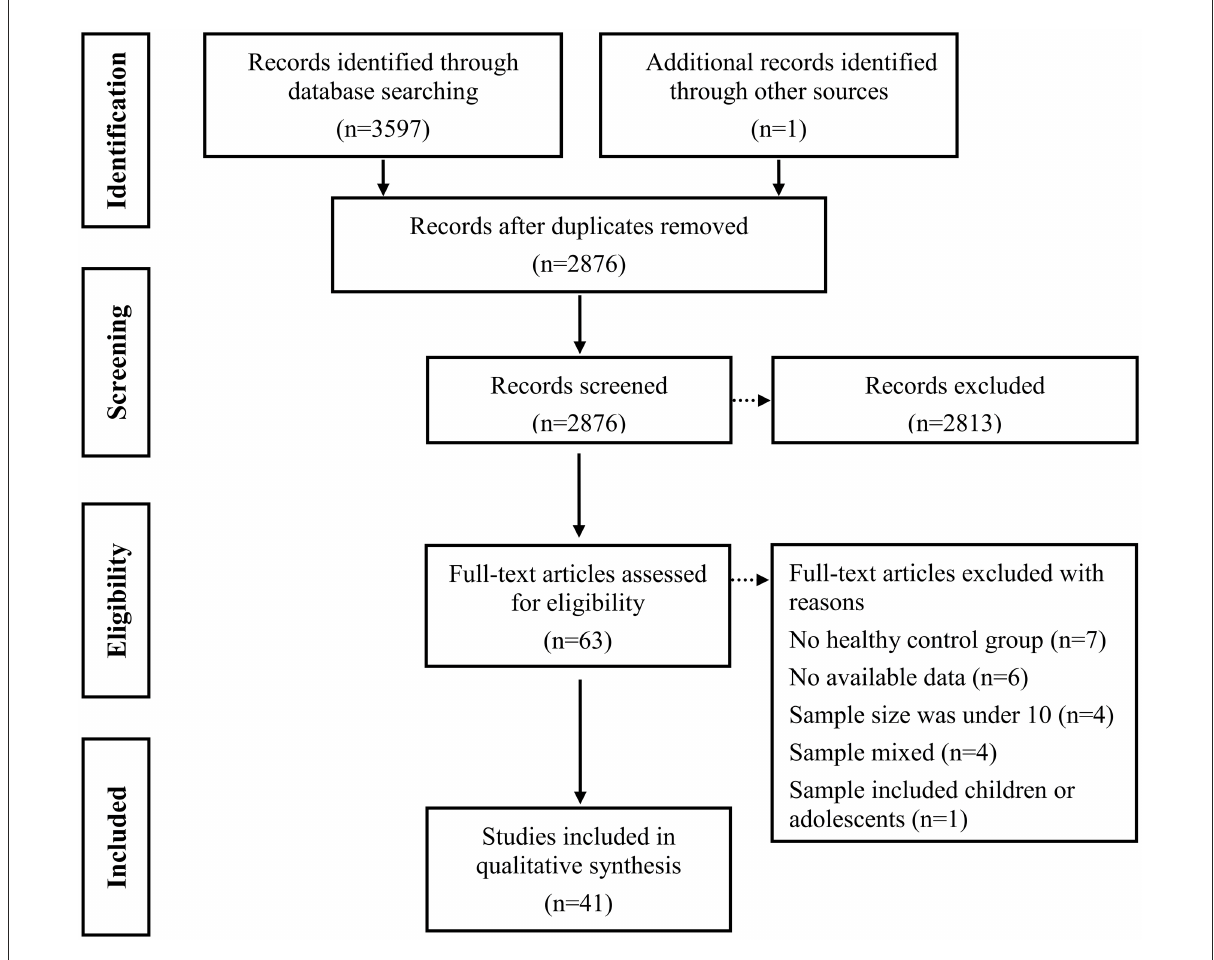
FIGURE1 Flowchart of identification and screening for the eligible